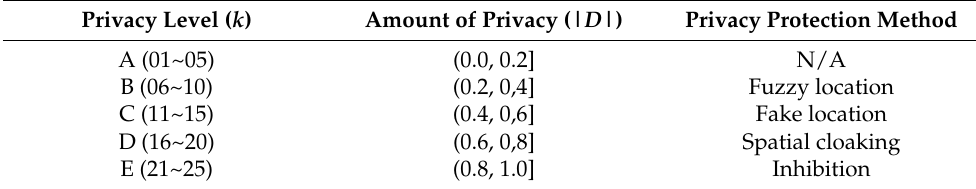
Table 1. Classified location privacy protection method. Privacy Level ( k